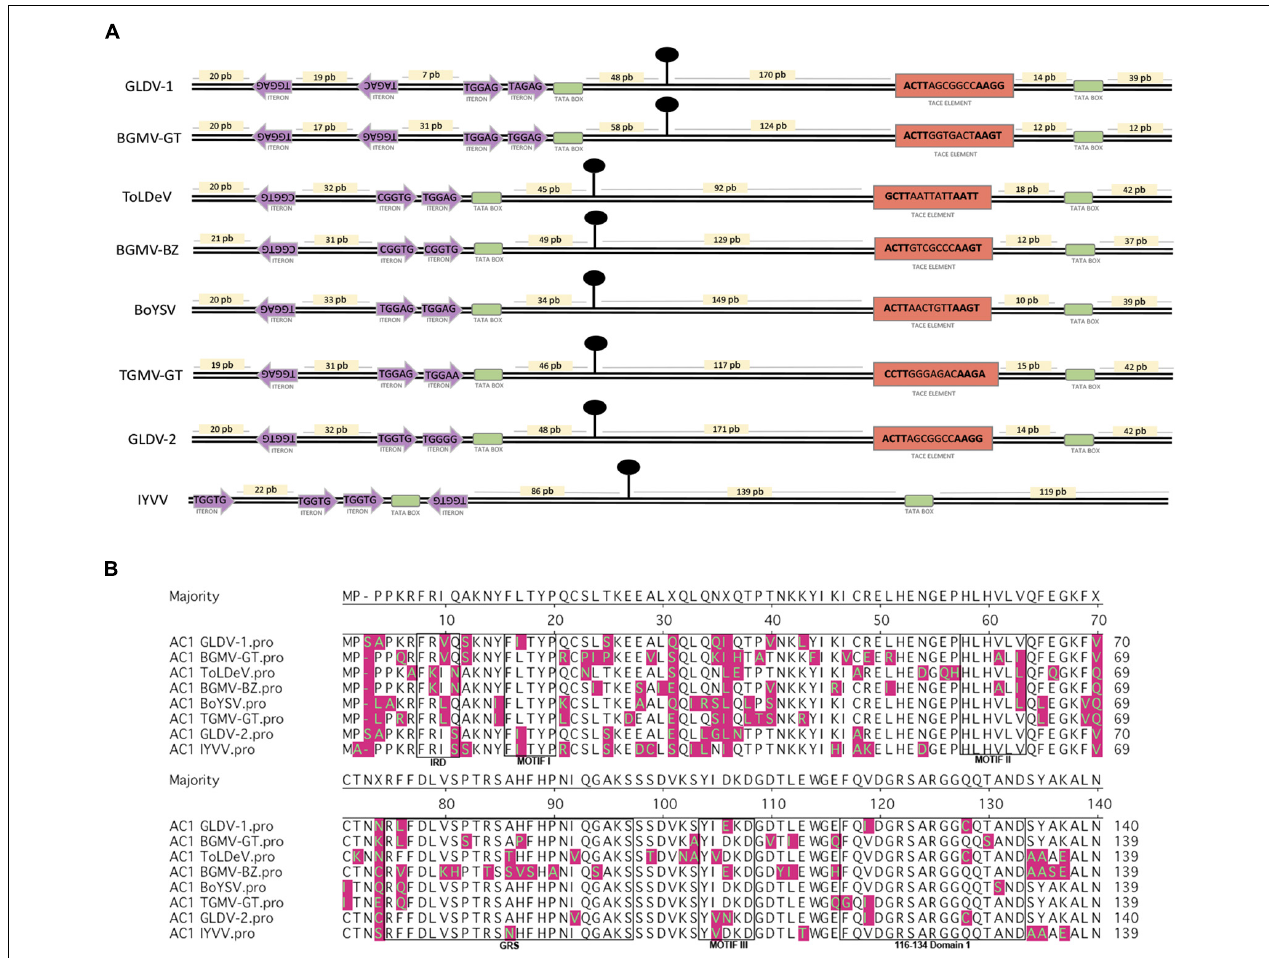
FIGURE 4 | Galium leaf distortion virus (GLDV) isolates replication/transcription regulatory elements analysis. (A) Comparative analysis of regulatory elements present in intergenic region (IR) of DNA-A components of GLDV isolates and selected NW begomoviruses. Arrangement and sequence of replication-associated iterated elements (iterons), and TATA-associated composite element (TACE), are shown in violet arrows and orange rectangles, respectively. For TACE element, dyadic four bases element is shown in bold. Replication origin and TATA-boxes, are indicated by black circles and green boxes, respectively. Nucleotide distances between regulatory elements is shown in yellow boxes. (B) Comparative analysis of N-terminal region (140 aa) of AC1 proteins of GLDV isolates and selected NW begomoviruses. Iteron-related domain (IRD), Motif I, II, III, and GRS, and 116–134 motifs are indicated. Differential amino acid residues compared with sequence consensus are indicated in magenta. Begomovirus accession numbers and acronyms are summarized in Supplementary Table 1